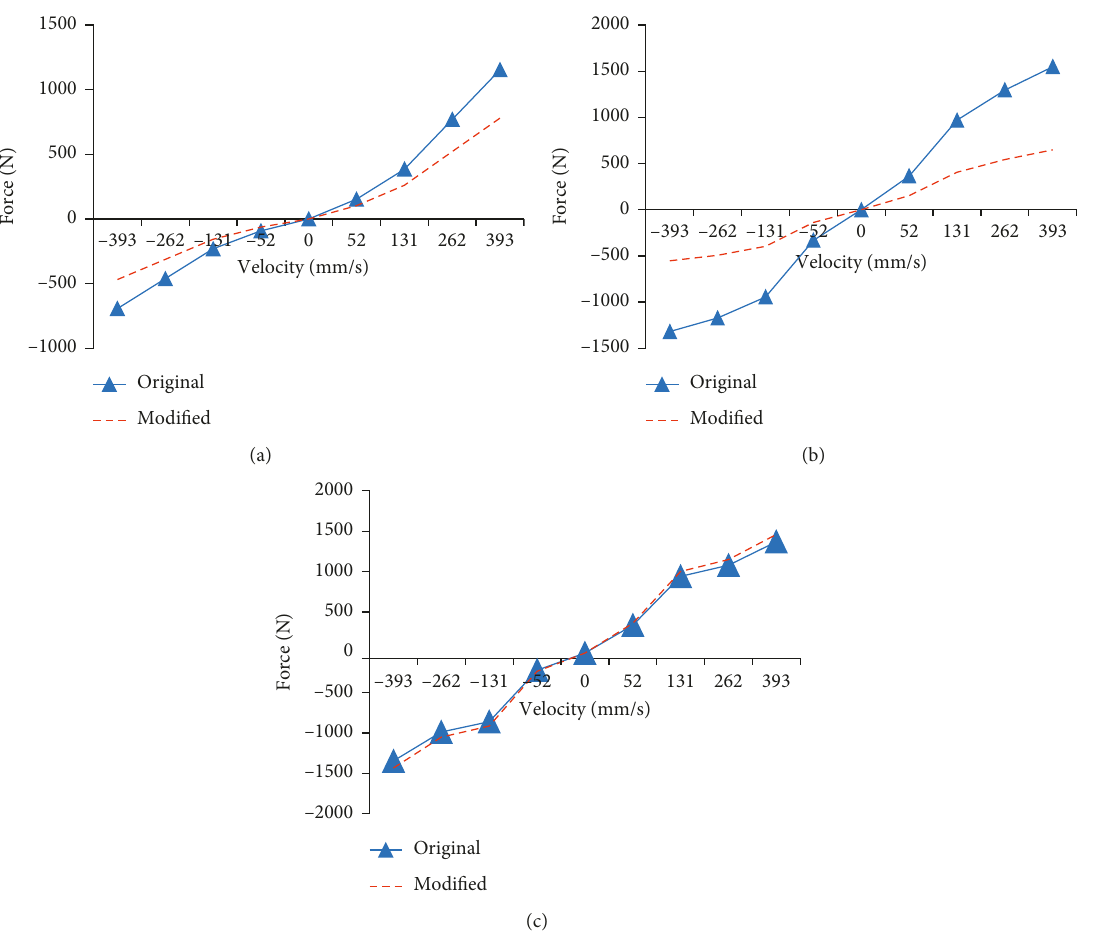
Figure 9: Comparison of nonlinear damping characteristic curves of (a) cab front suspension, (b) cab rear suspension, and (c) cab rear suspension.